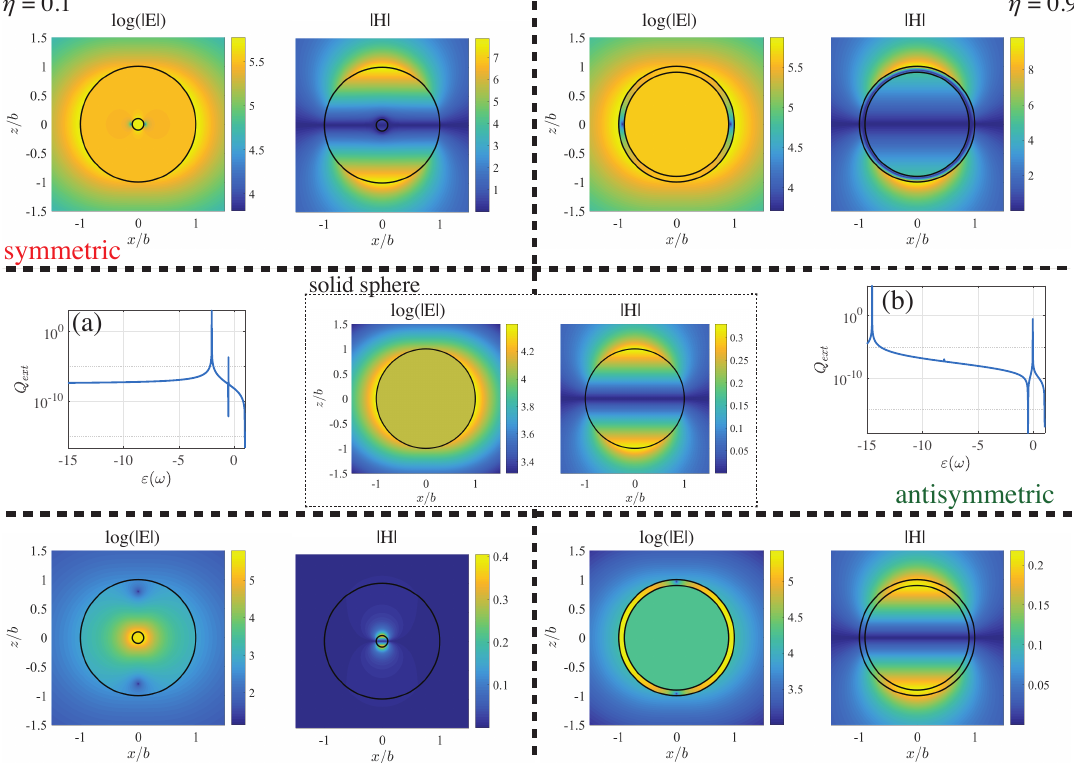
Figure 6. Electric and magnetic field distribution (amplitude) of the symmetric ( top ) and antisymmetric ( bottom ) plasmonic resonances of a very small ( x = 0.01) core–shell sphere occurring for η = 0.1 ( left ) and η = 0.9 ( right ) radius ratio, respectively. The inset figures depict the scattering spectrum (extinction efficiency) for ( a ) η = 0.1 and ( b ) for η = 0.9. The center pictures illustrate the field distribution (electric and magnetic) of the plasmonic resonance for a solid sphere for